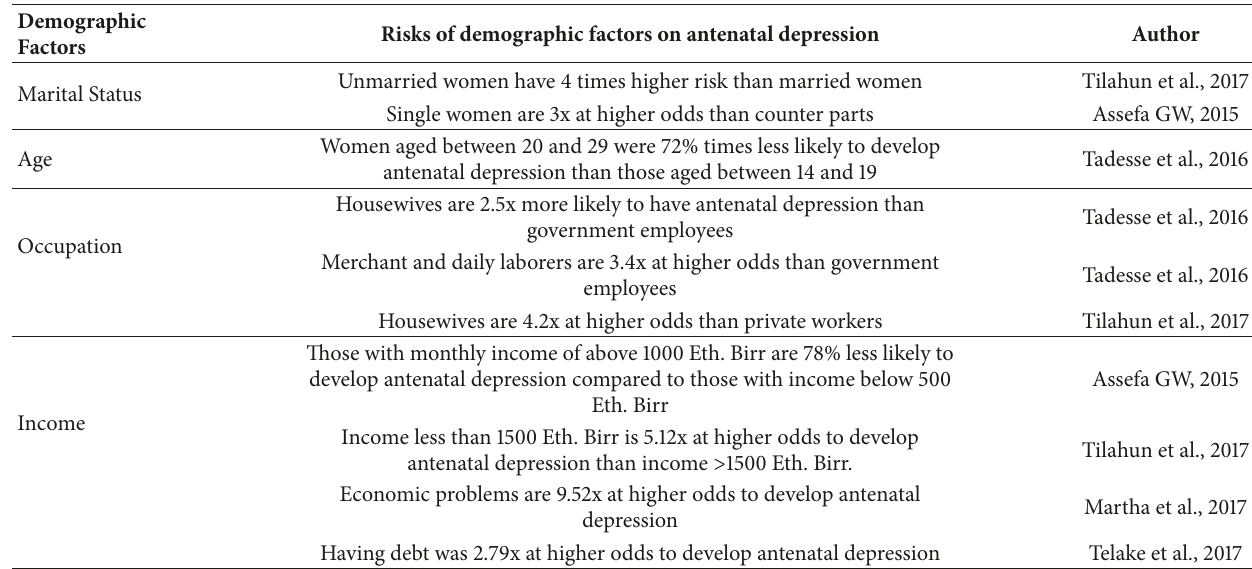
Figure 3: Pooled effect of unplanned pregnancy on antenatal depression in Ethiopia. Table 3: Demographic risk factors of antenatal